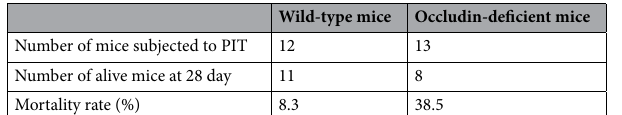
Table 1. Mortality rate after cerebral infarction. PIT : Photochemically Induced Thrombosis stroke